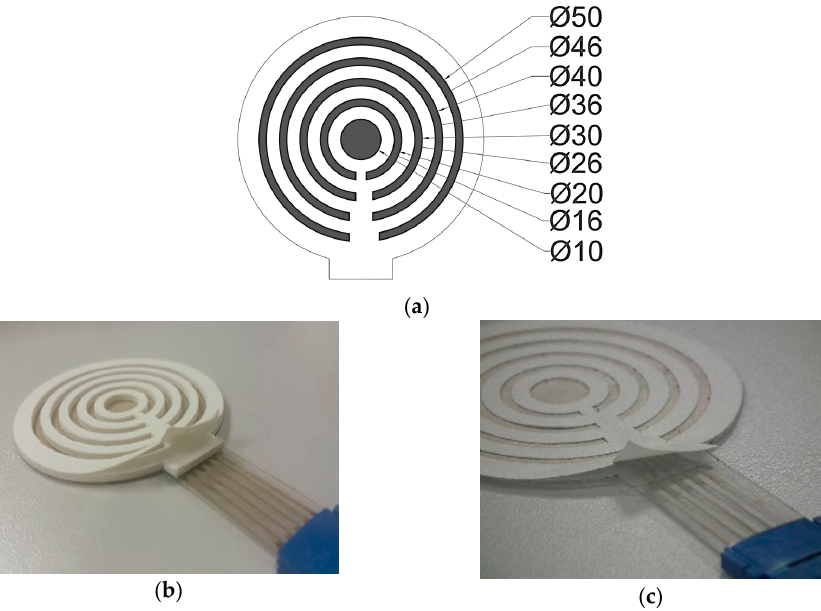
Figure 3. ( a ) Template design, size in mm; ( b ) Multi-CRE with foam; ( c ) Multi-CRE with adhesive.